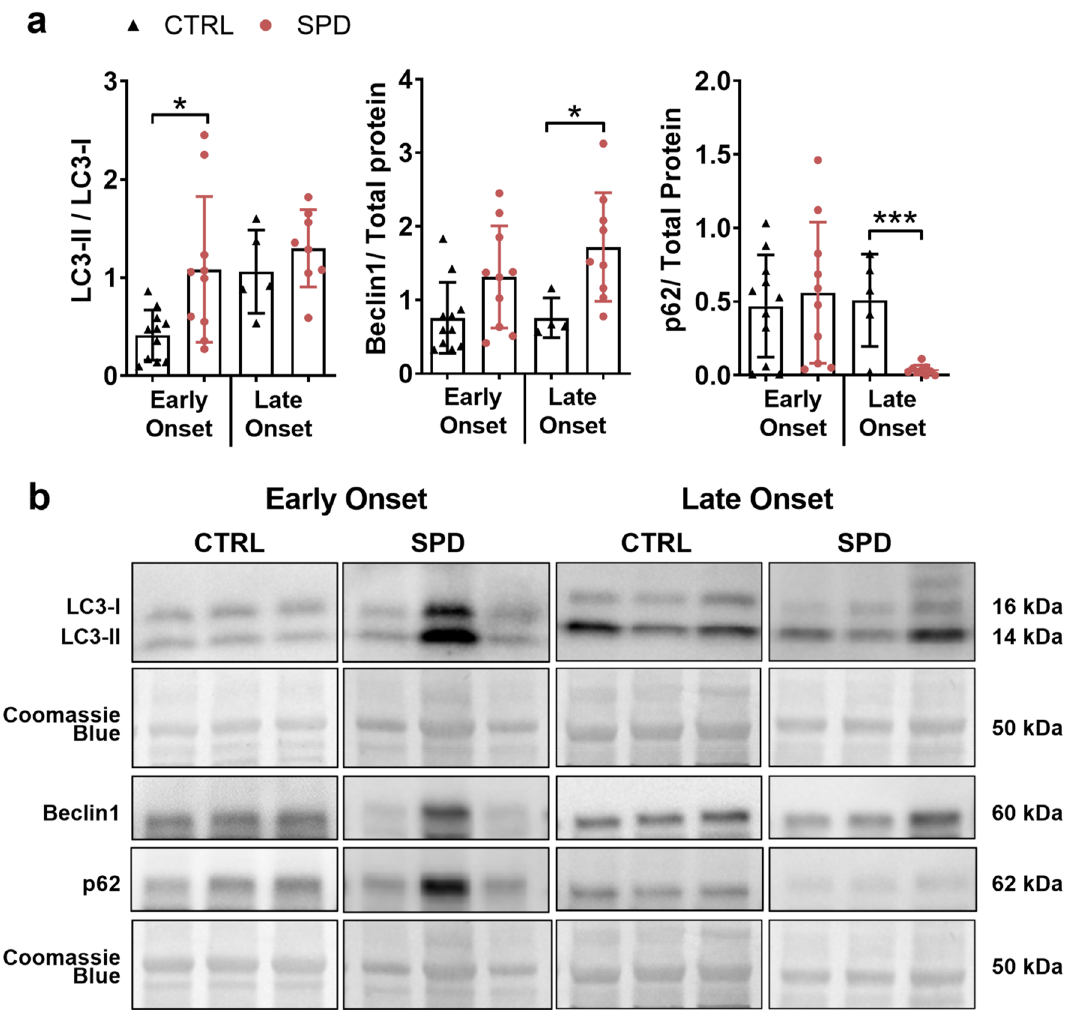
Figure 4. Daily oral spermidine treatment increased autophagy in female late onset mice. Diabetic mice were grouped as early onset (< 21 weeks of age) and late onset (≥ 21 weeks of age). Samples were probed for